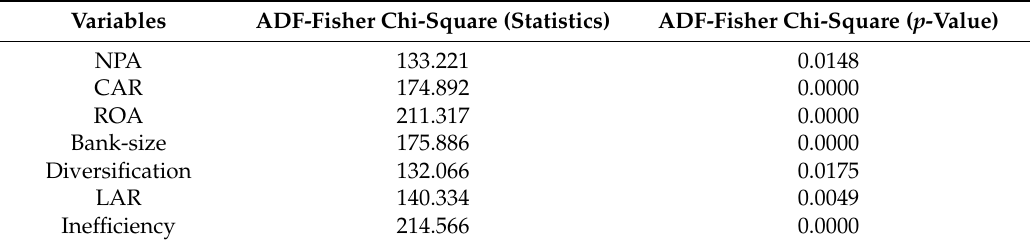
Table 3. Panel unit root test